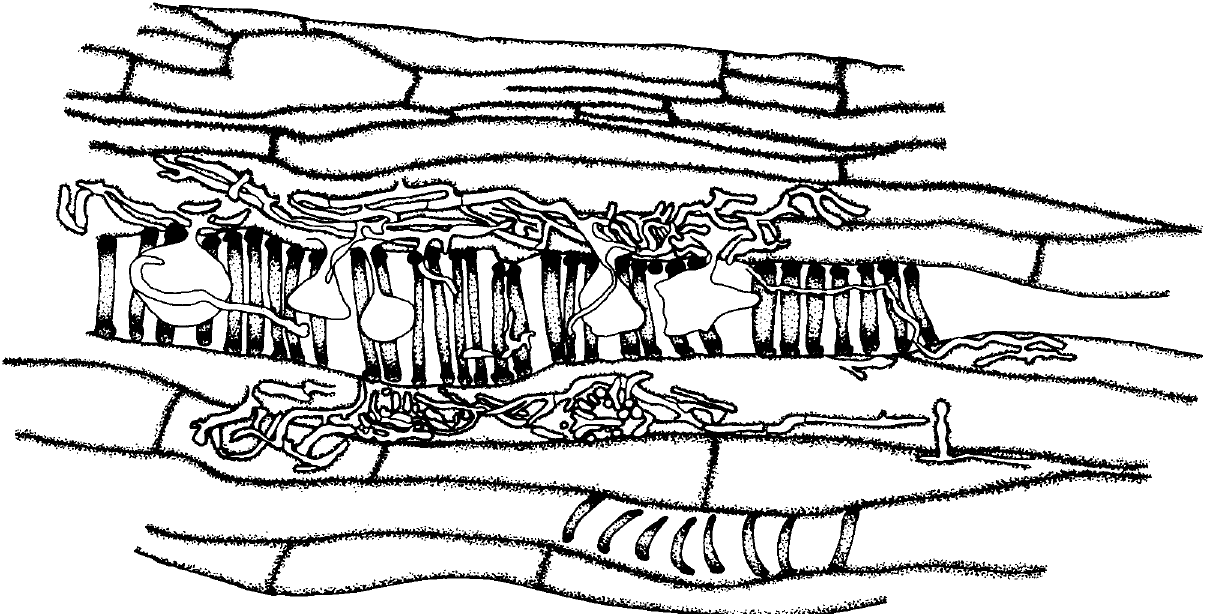
Fig. 2. Phaeoacremonium chlamydosporum - mycelium and tyloses in xylem parenchyma cells and vessels of artifi- cially inoculated tissue cultured Chardonnay